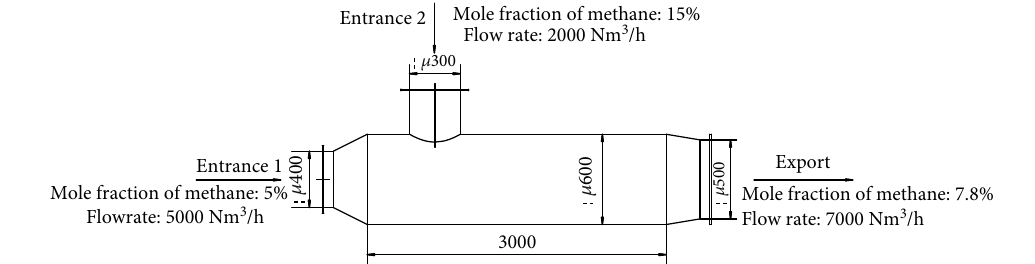
Figure 1: Geometry of the 7000 Nm 3 /h gas mixing unit.